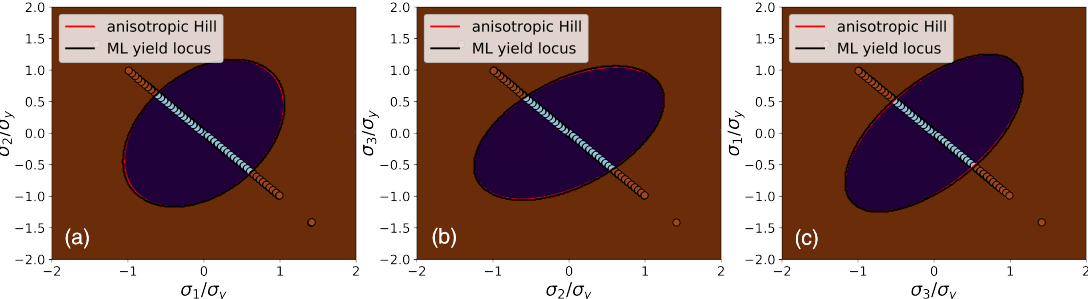
Figure 4. Color map of the trained SVC prediction of the yield function in slices through the principal stress space defined by plane-stress conditions: ( a ) σ 3 = 0; ( b ) σ 1 = 0; ( c ) σ 2 = 0. Brown regions indicate values of “+1” (plasticity) and purple regions values of “-1” (elasticity). The ML yield locus, corresponding to the isoline for f SVC = 0, is represented as a black line; the yield locus of the Hill-like anisotropic reference material is indicated as a red line. The training data points are plotted with the same color code as in Figure